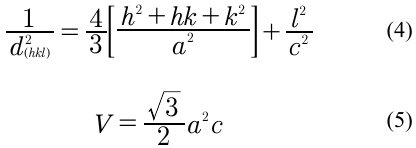
Table 1. Structural parameters including crystallite size (D), dislocation density (δ), micro-strain (ε), lattice parameters (a and c), unit cell volume (V), internal relaxation parameter (u) and bond length (b B Concentration